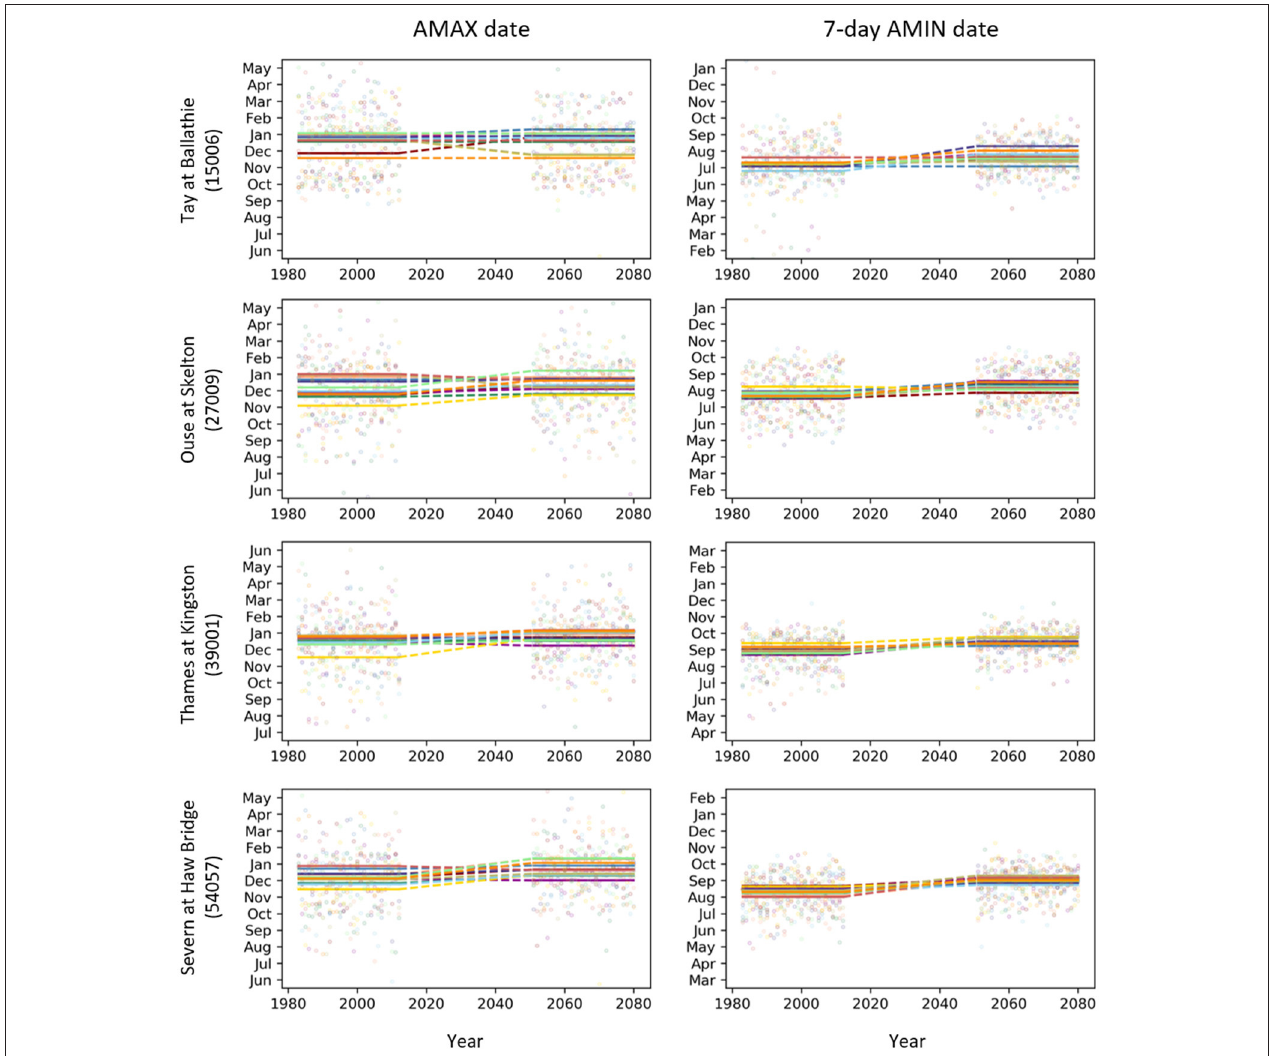
FIGURE 6 | Timing of annual maximum flows (left) and 7-day annual minimum flows (right) for the four example catchments over the baseline and future periods. Colours represent the different ensemble members. Points show the timing of individual events, whilst lines show the average date of events over the full baseline/future